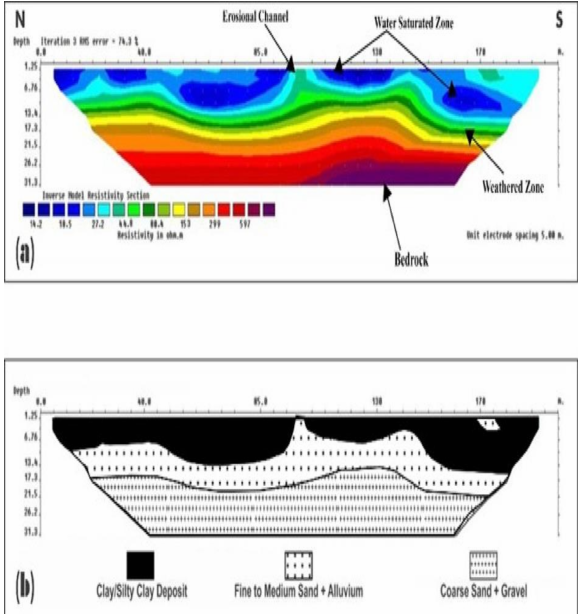
Fig. 7. (a) Profile 5 electrical resistivity tomography; (b) Geologic cross-section interpreted from the resistivity model within a sequence of horizontal sedimentary sequence (see Fig.